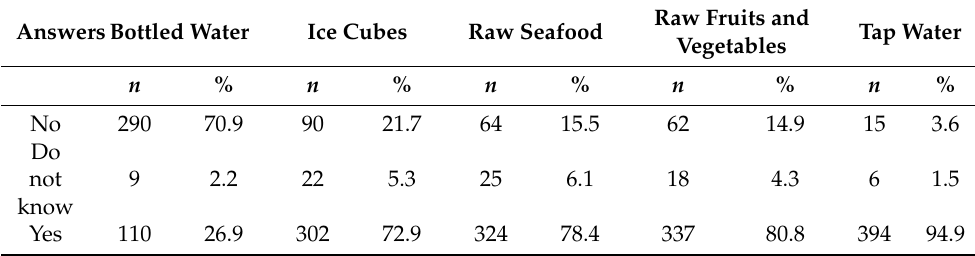
Table 3. Food and drink risk perception among